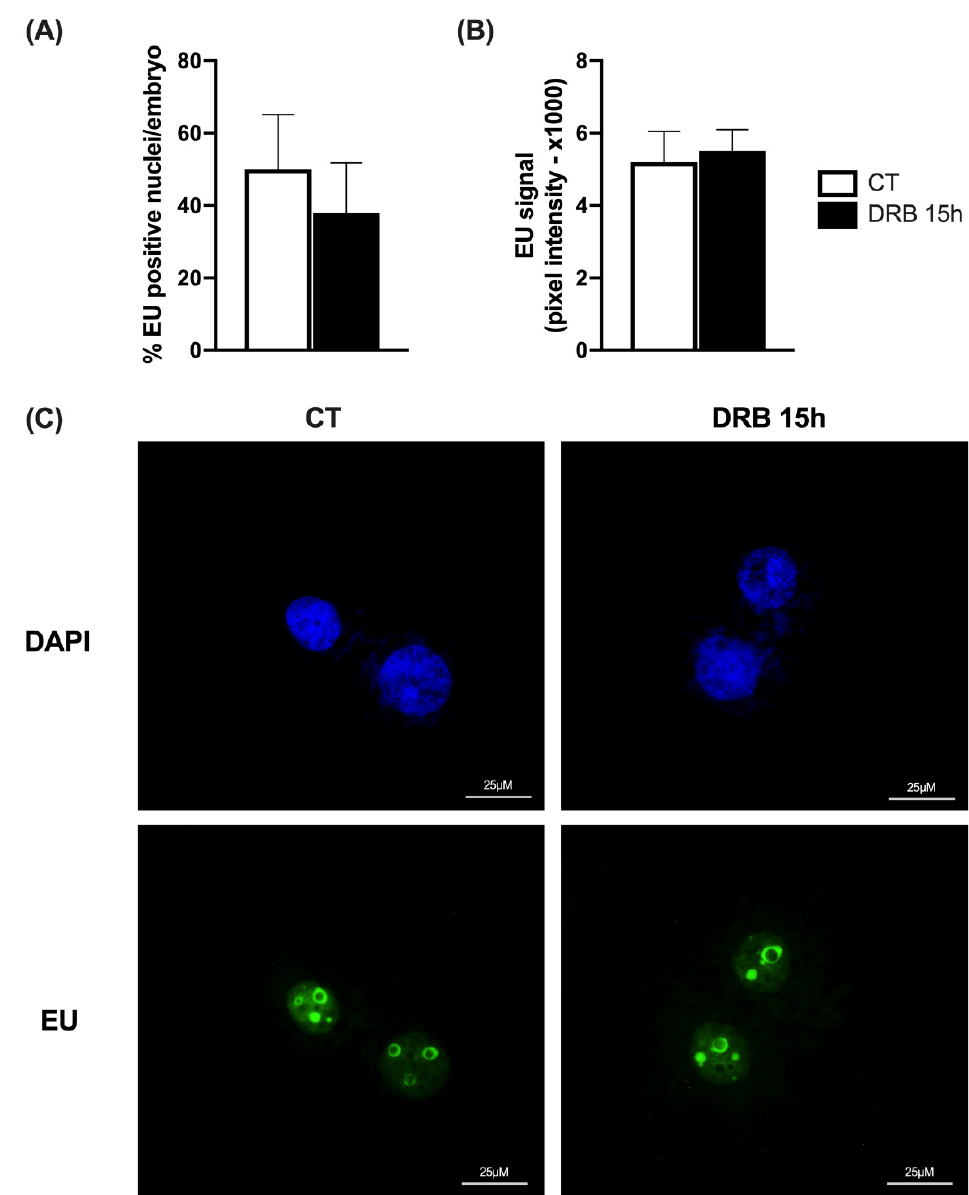
Figure 3. Assessment of new RNA synthesis by EU incorporation on D3 SCNT embryos. ( A ) Pro- portion of nuclei per embryo with positive staining for EU in SCNT embryos treated for 15 h with Scriptaid only (CT, n = 12) or Scriptaid + DRB (DRB, n = 12). ( B ) Pixel intensity for EU incorporation in CT (n = 12) and DRB (n = 12) nuclei. ( C ) Representative fluorescent images showing DAPI and EU staining. There was no statistical difference between CT and DRB groups.